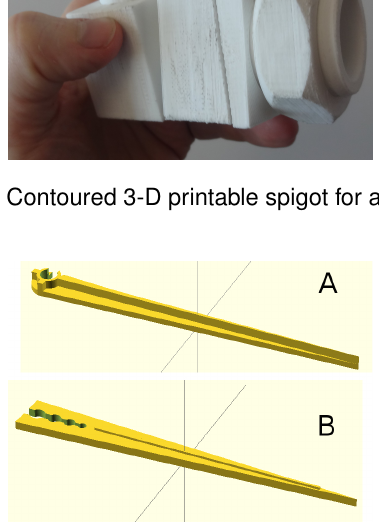
Figure 18. 3-D printable garden stakes used for